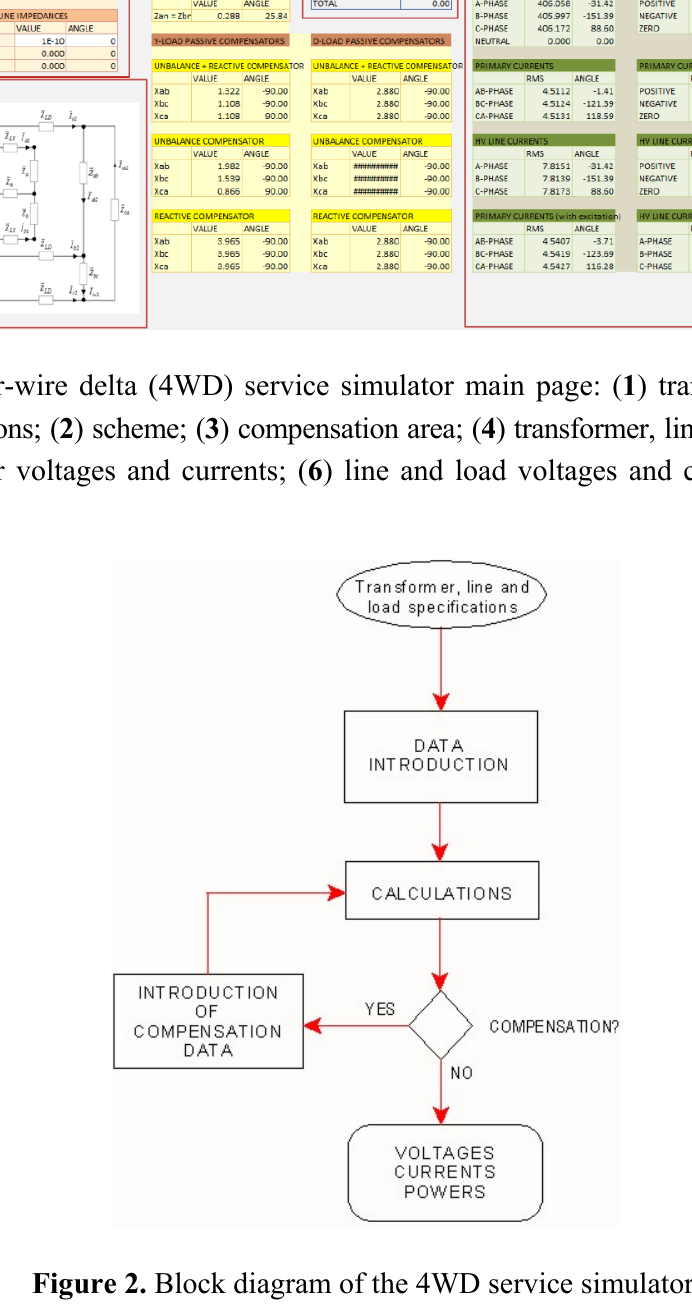
Figure 2. Block diagram of the 4WD service